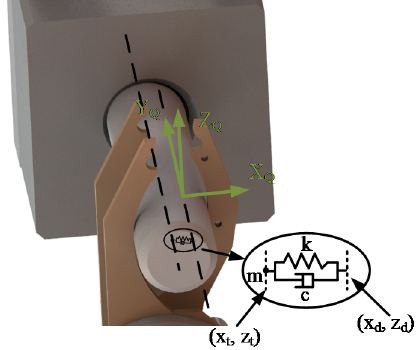
Figure 11. The virtual mass-spring-damper model.